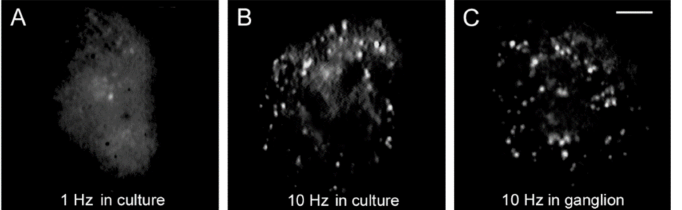
Figure 3. Somatic exocytosis as measured from FM1-43 fluorescence staining. ( A ) The fluorescent FM1-43 spots after stimulation with a 1 Hz train correspond to constitutive exocytosis. ( B ) Increase in the number of fluorescent spots after a 10 Hz train. ( C ) Similar staining pattern in the soma of a neuron stimulated in the ganglion. Scale bar = 10 µ m. Obtained with permission from [32].